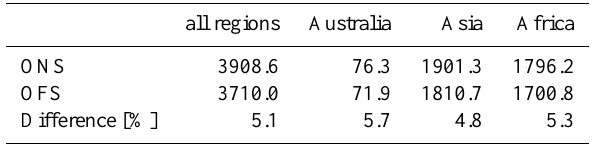
Table 3. Annual dust emission amounts (Tgyr − 1 ) of the OFS ver- sus the ONS for the entire world, Australia (106.9 ◦ E–157.5 ◦